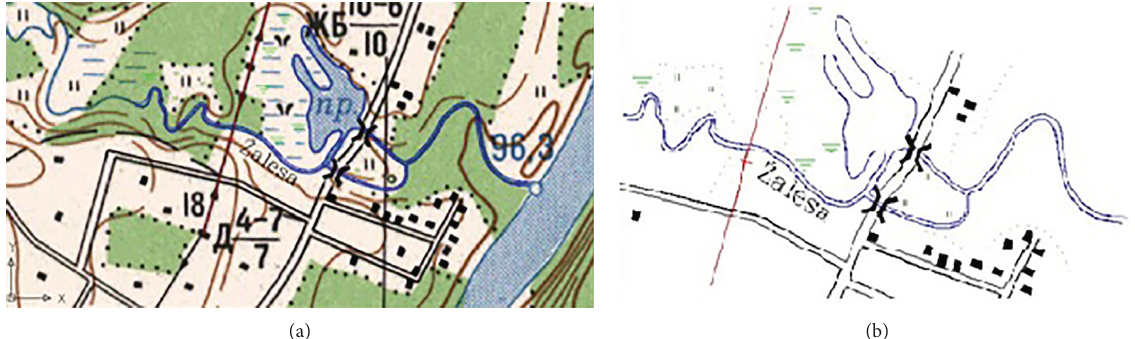
Figure 8: Digitized section of River ˇZalesa is represented in the topographic map of 1986 (source: http://www.geoportal.lt).